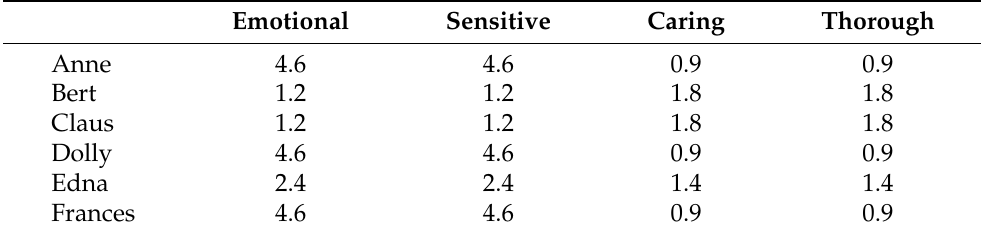
Table 4. Matrix of situation 4: “meeting a new date” for behavioral level